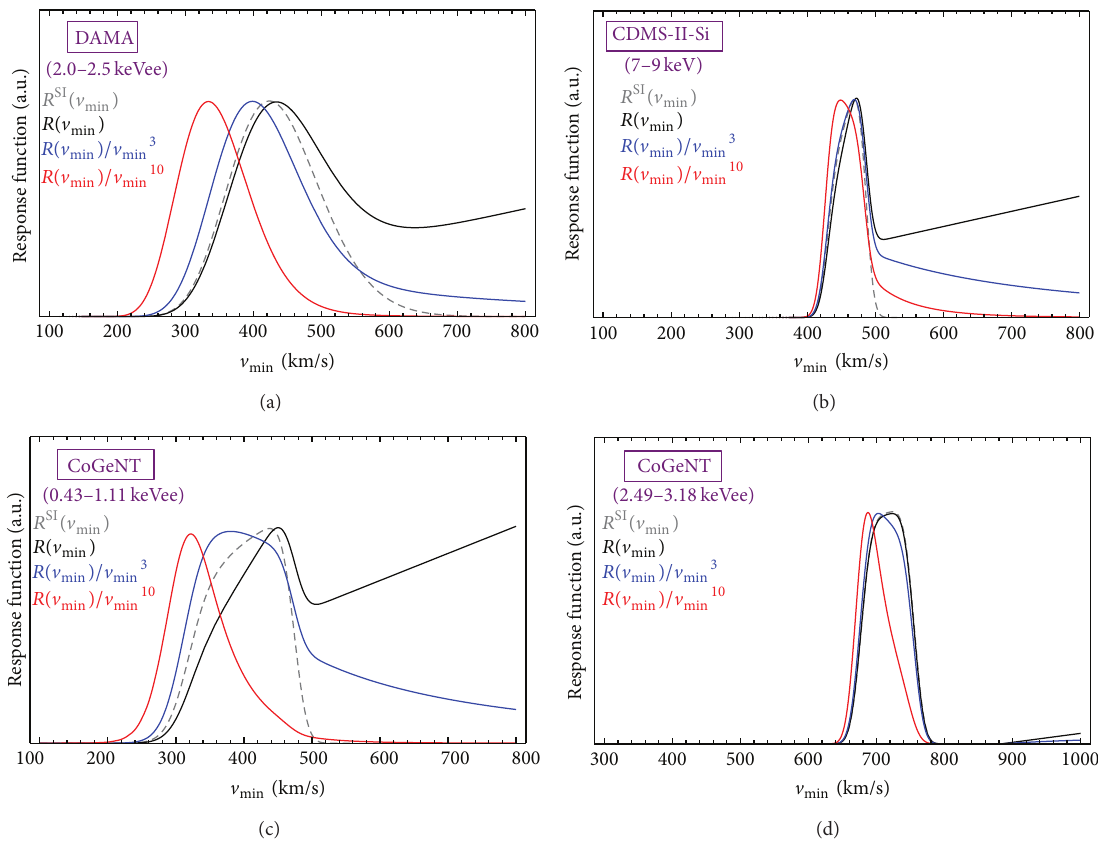
( V ) with arbitrary normalization for several detected energy intervals and detectors for SI 󸀠 min 1 ,𝐸 2 ]